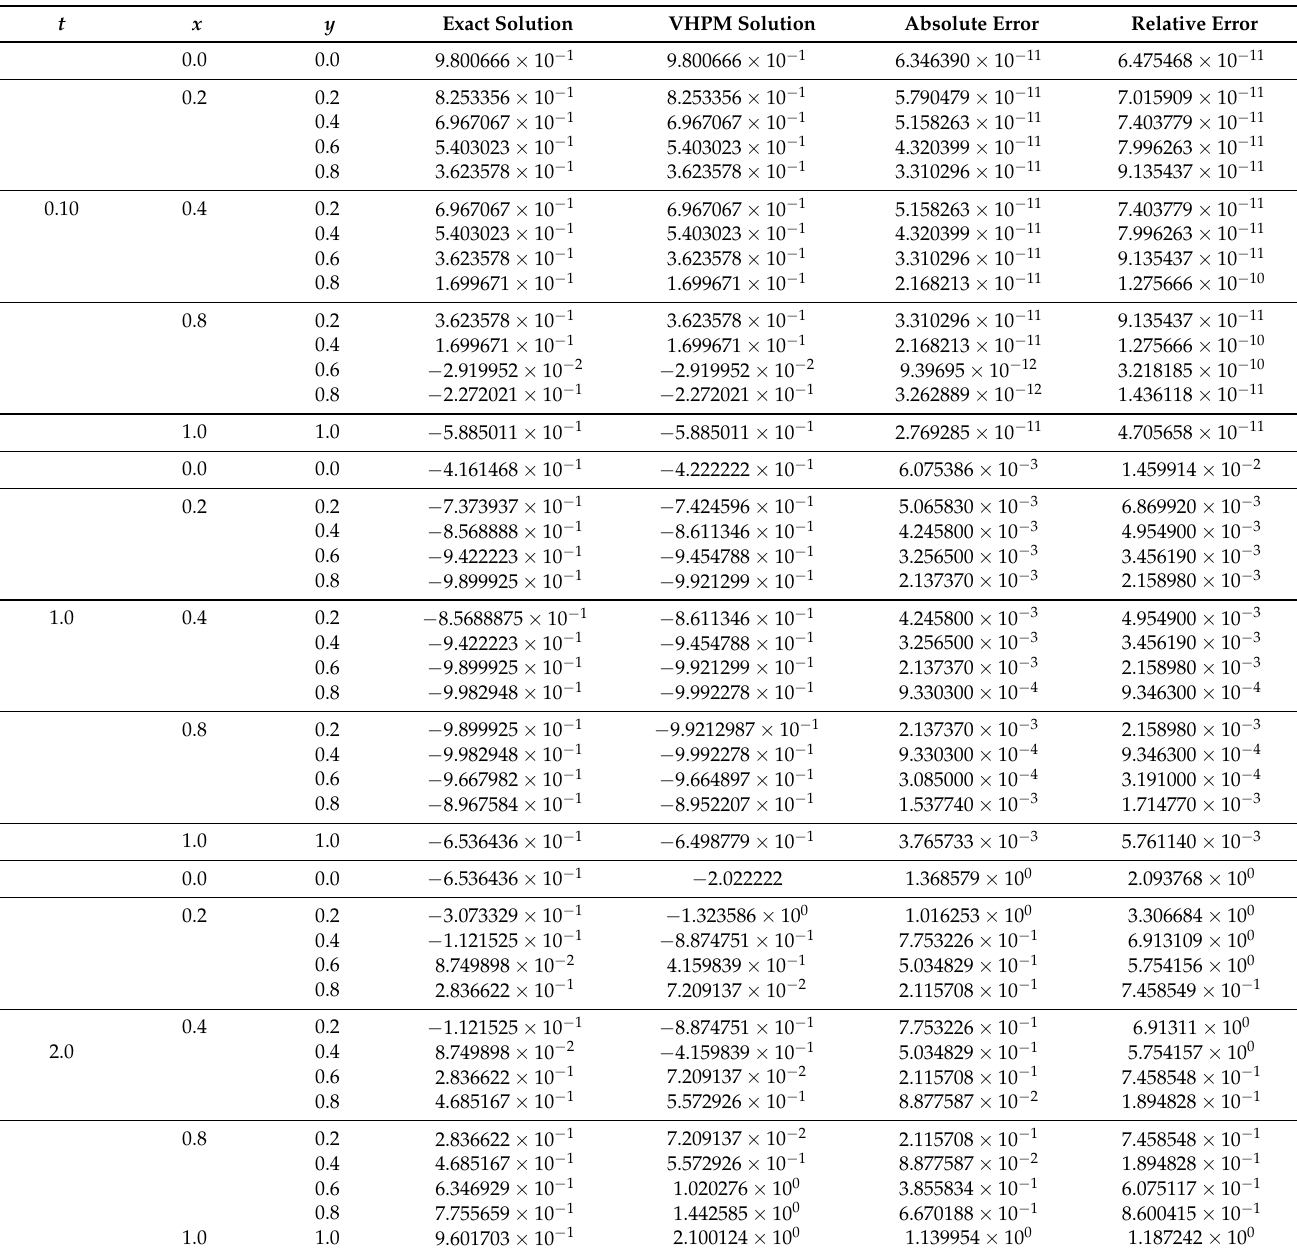
Table 2. A comparison between the exact solution and VHPM solution at some values of x and y at time t = 0.10, 1.0,